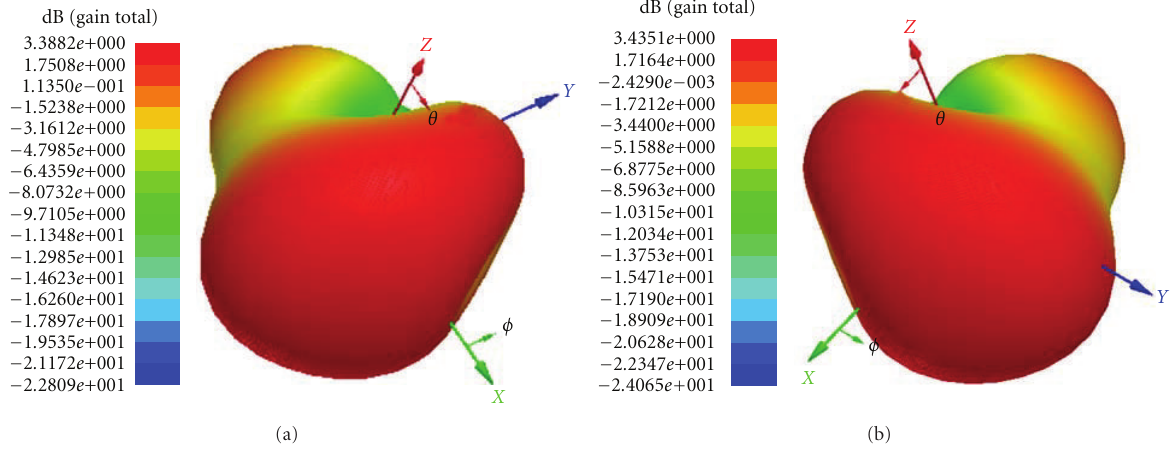
Figure 6: Simulated 3D radiation pattern at 1.9 GHz. (a) Antenna 1 excited. (b) Antenna 2 excited.